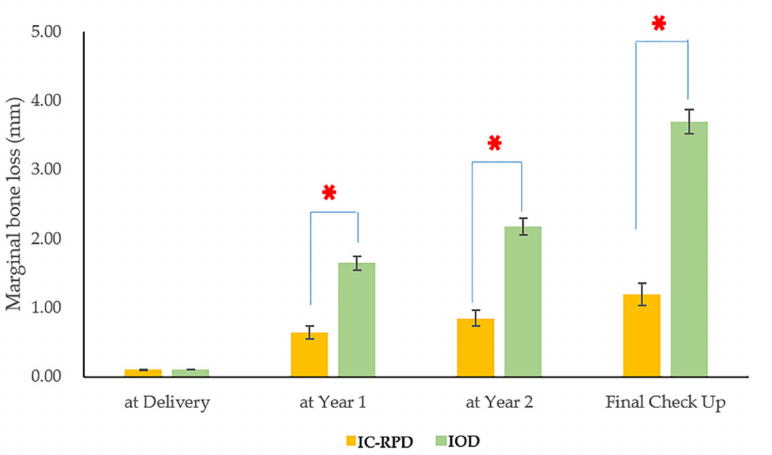
Figure 4. Marginal bone loss of failed implants.